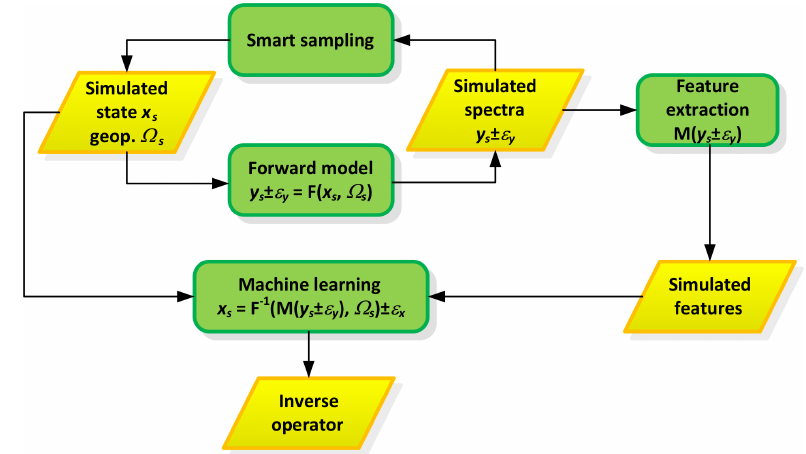
Figure 1. Data flow diagram for the FP_ILM training phase. The smart sampling technique creates simulated state vector x s and geophysical conditions (cid:127) s that are used as input for the forward model for the calculation of simulated spectra, with their expected errors y s + e y . Machine learning techniques are deployed for computing the inverse operator, which is trained using the features extracted from simulated spectra M(y s ) and geophysical conditions (cid:127) s as input, and the state vector and the errors x s + e x as